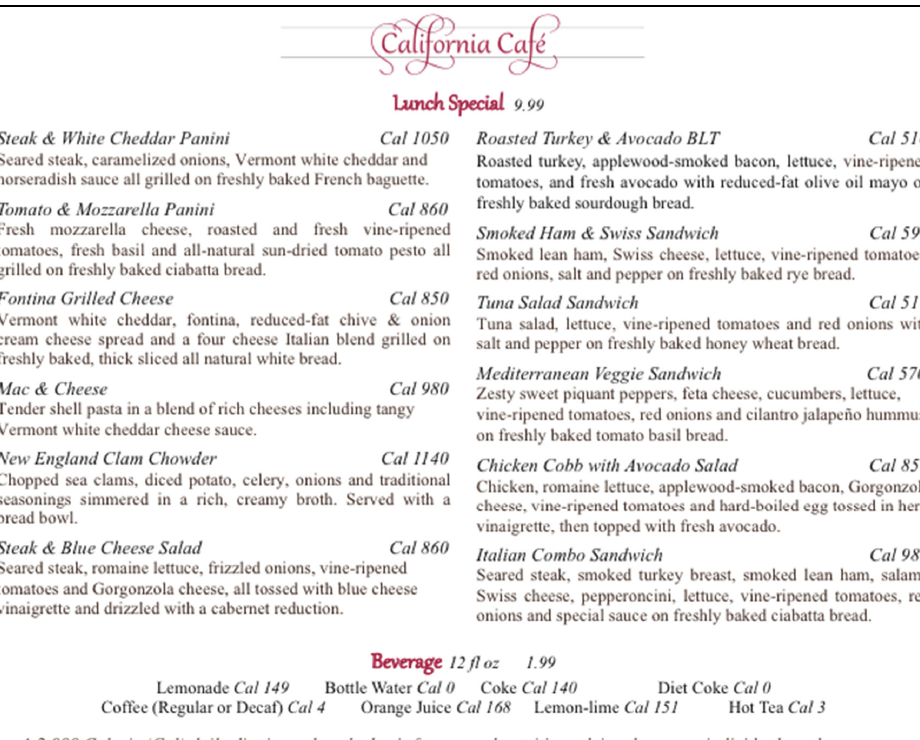
Figure A6. California Cafe First and Last Menu.